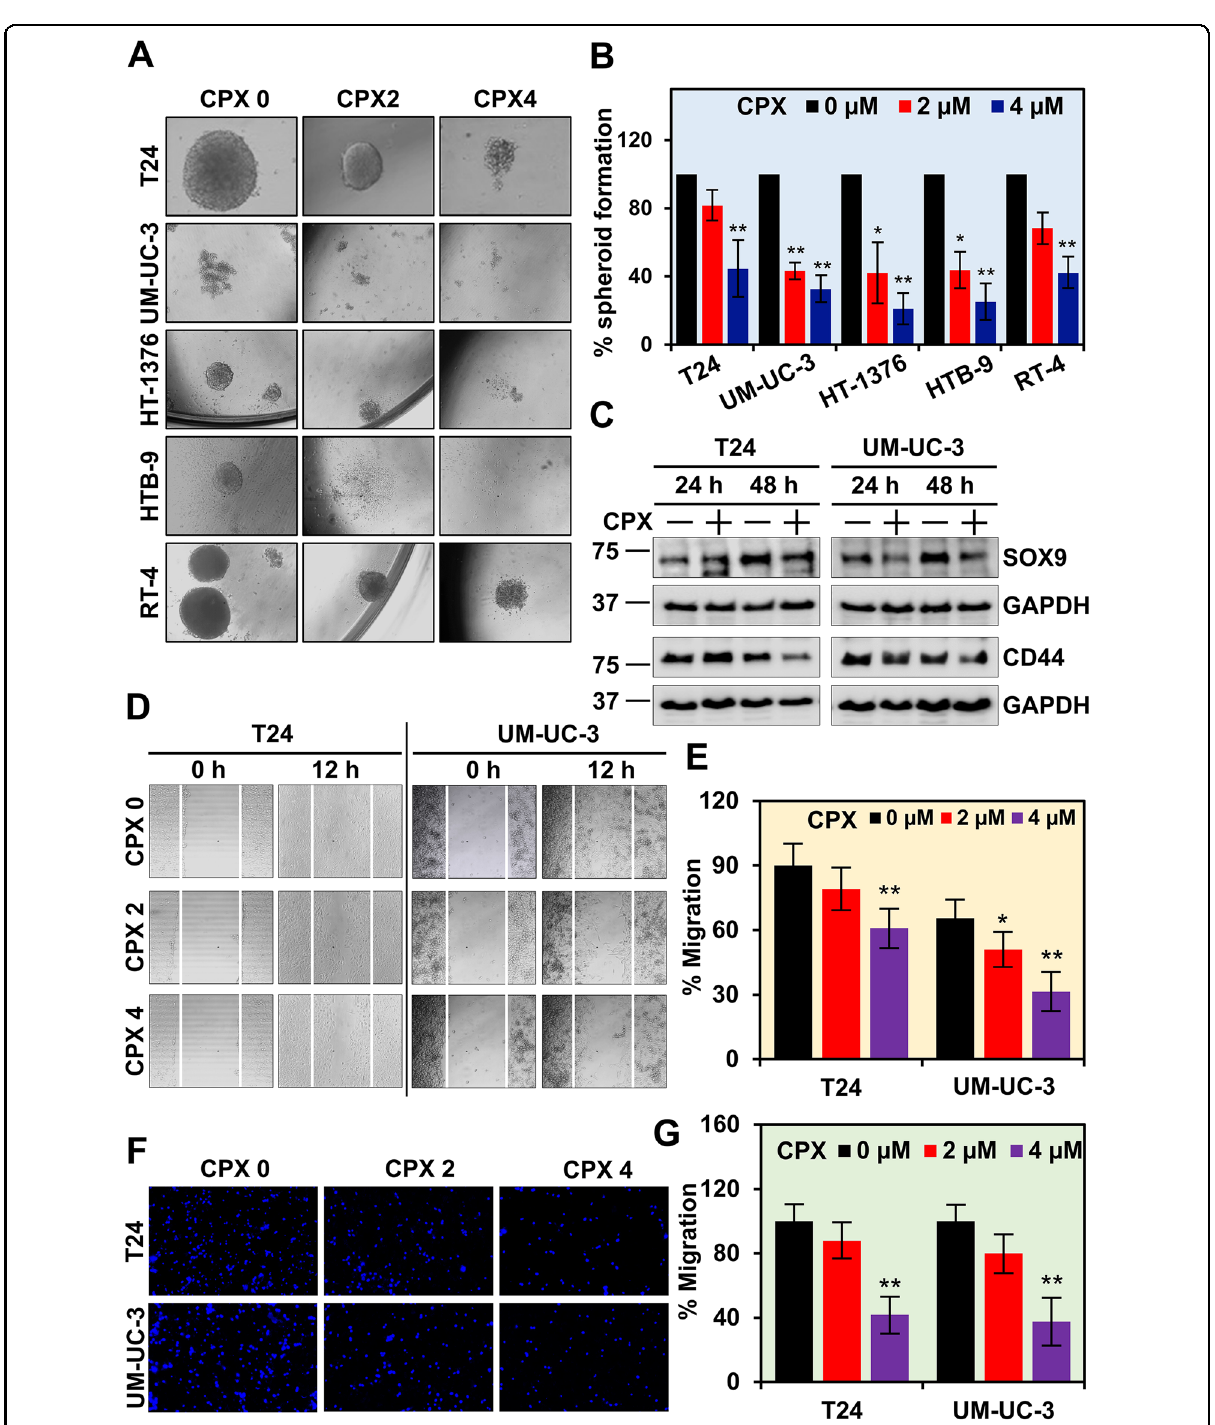
Fig. 4 CPX inhibits bladder cancer spheroid growth and cell migration. A, B CPX inhibits spheroid growth. CPX suppressed the size ( A ) and number ( B ) of spheroids of bladder cancer cell lines. Cells were grown in spheroid growth media in ultralow adherent plates and treated with CPX 2µM and 4µM concentrations for 5 days. CPX signi fi cantly decreased bladdosphere formation in the T24, UM-UC-3, HT-1376, HTB-9, and RT-4 cell lines. C CPX inhibits the expression of bladder cancer stem cell marker proteins. Lysates from T24 and UM-UC-3 cell lines after CPX treatment were subjected to western blot analysis. CPX treatment inhibited the expression of SOX9 and CD44 in both cell lines. D CPX inhibits migration of T24 and UM-UC-3 cells. Both cell lines were grown to 95 – 100% con fl uency and a scratch was made to study the cell movement over a period of 12h. CPX treatment reduced cell migration. E CPX inhibited the percent migration in both cell lines. F CPX inhibits migration of T24 and UM-UC-3 cells. CPX treatment signi fi cantly reduced the migration of both cell lines through transwell cell culture inserts (Boyden ’ s chamber). G The percent migraition is represented in graphical format.